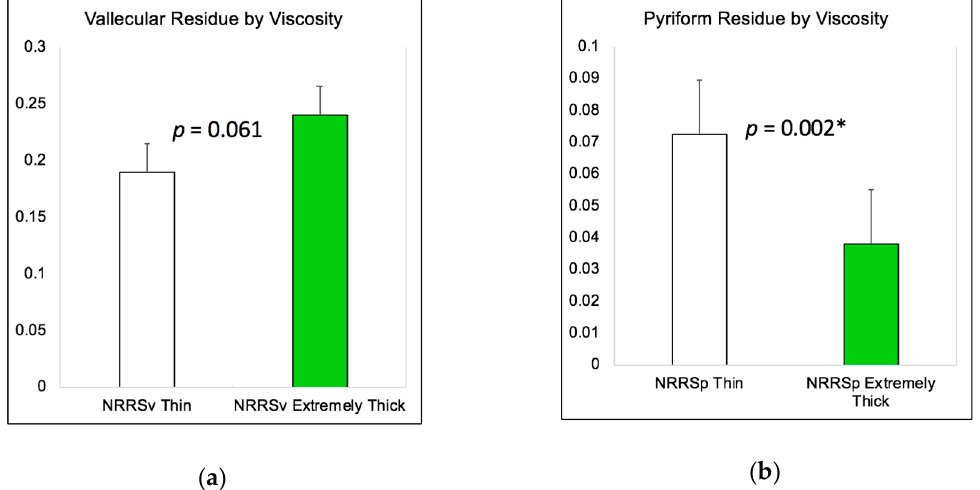
Figure 2. ( a ) Bar graph depicting in differences in vallecular residue (NRRSv) by bolus viscosity; ( b ) Bar graph depicting in differences in pyriform sinus residue (NRRSp) by bolus viscosity. * p ≤